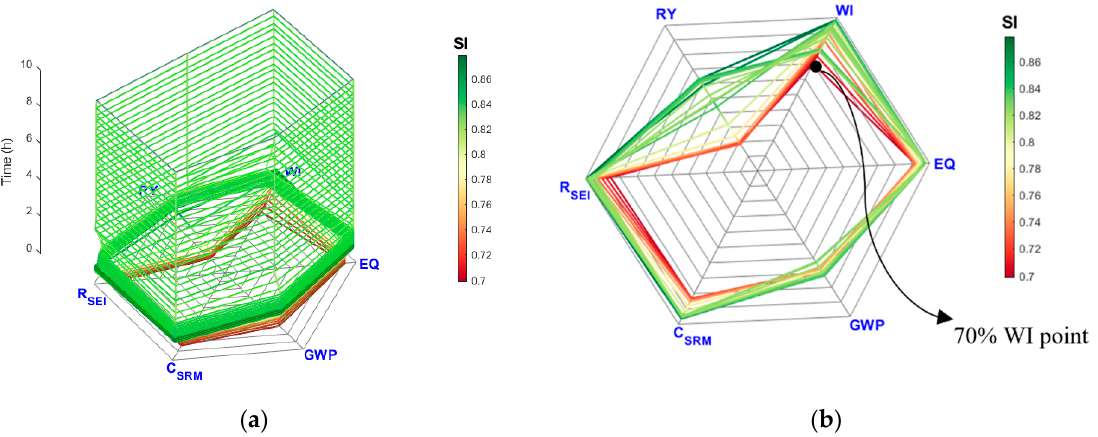
Figure 9. Case 1—dynamic sustainability performance with sustainability constraint: ( a ) 3D sustainability indicator dynamic radar plot; ( b ) 2D projection of sustainability indicator radar plot.